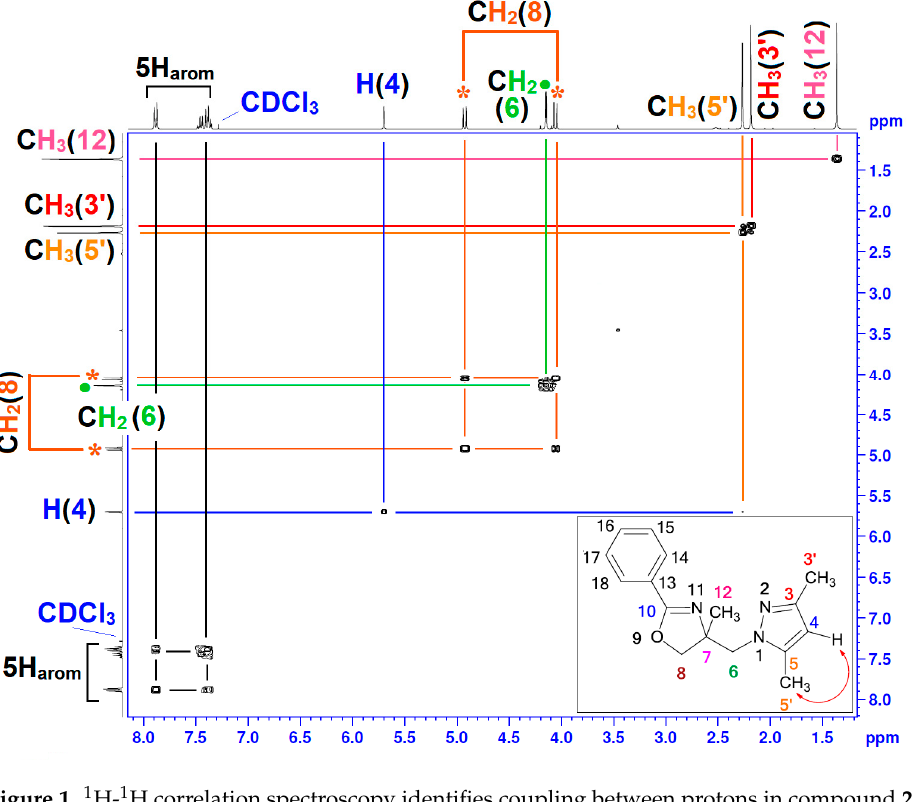
Figure 1. 1 H- 1 H correlation spectroscopy identifies coupling between protons in compound 2 .